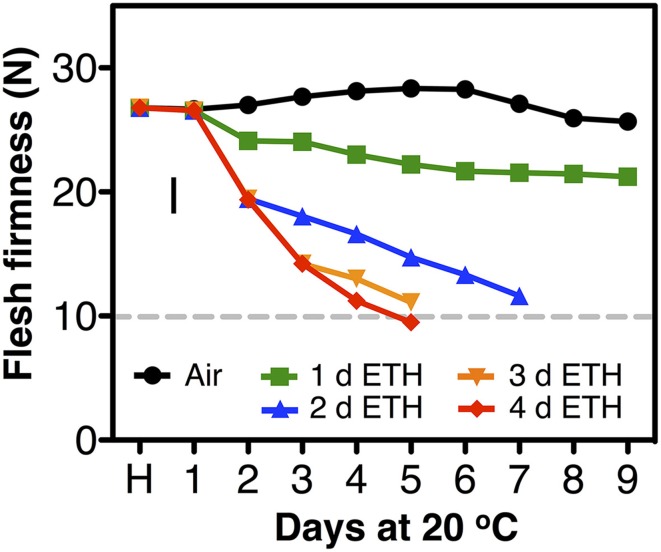
Postharvest softening response of “Roysum” plums to exogenous ethylene. Immediate flesh firmness changes following harvest (H) of the suppressed-climacteric “Roysum” plum cultivar in response to exogenous ethylene (ETH, 10 μL L−1) for 0, 1, 2, 3, or 4 d and subsequent transfer to ambient (ethylene-free) air for up to 9 d at 20°C and 90% RH. The horizontal dotted line marks the 10-N flesh firmness threshold of the “ready-to-eat” stage. The vertical bar represents the least significant difference (LSD, P = 0.05).